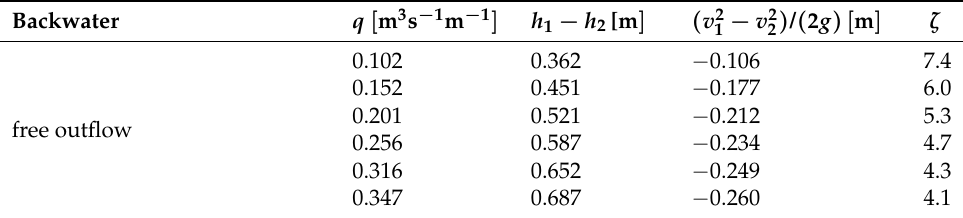
Table 2. Measurement results from this study for the three investigated backwater conditions and measured specific discharges q . The flow depth and velocity data belong to a cross-section directly in front of the rack (median values at 20 m < x < 21 m) and to the median values from the three stationary measurement locations behind the rack. The third and fourth column express the flow depth differences and the velocity head differences, respectively. The fifth column presents the sudden loss coefficients ζ determined from the Saint-Venant model based on the experiments from this study. − v 2 ) / ( 2 g ) [ m ] ζ Backwater q [ m 3 s − 1 m − 1 ] h 1 − h 2 [m ] ( v 2 2 1 0.102 free outflow